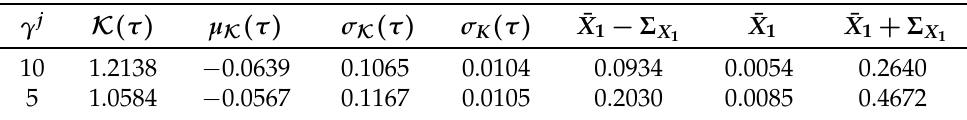
Table 5. Mean and Standard Deviation for Expected and Unexpected Gross Growth Rate of Trading Desk Manager’s